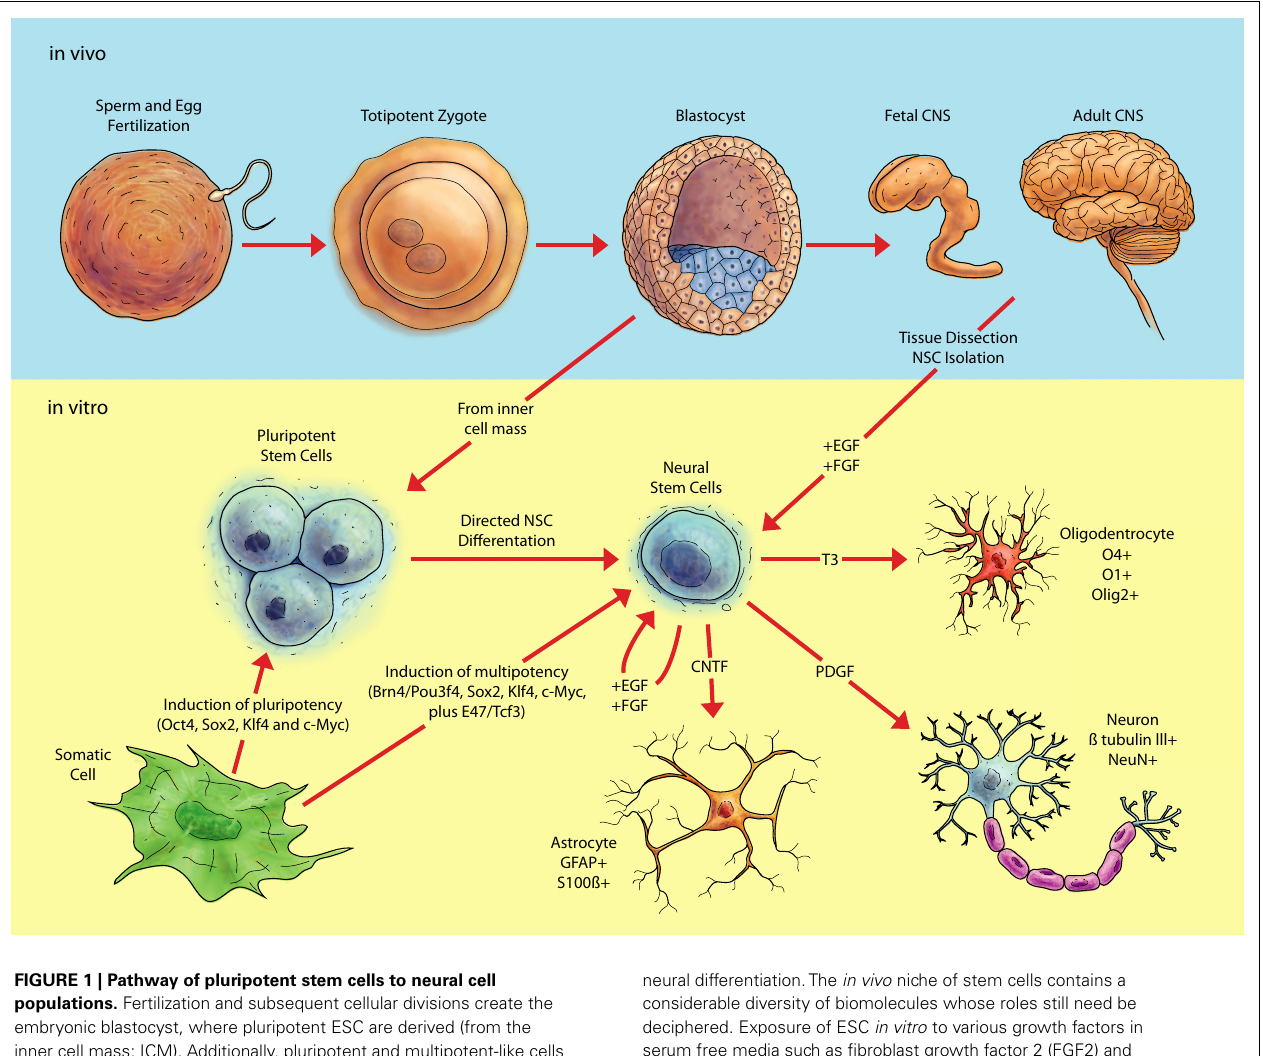
FIGURE 1 | Pathway of pluripotent stem cells to neural cell populations. Fertilization and subsequent cellular divisions create the embryonic blastocyst, where pluripotent ESC are derived (from the inner cell mass; ICM). Additionally, pluripotent and multipotent-like cells can be created via transduction of various factors into differentiated tissue, such as fibroblasts. In vitro analyses of pluripotent and multipotent neural stem cells are integral for understanding aspects of